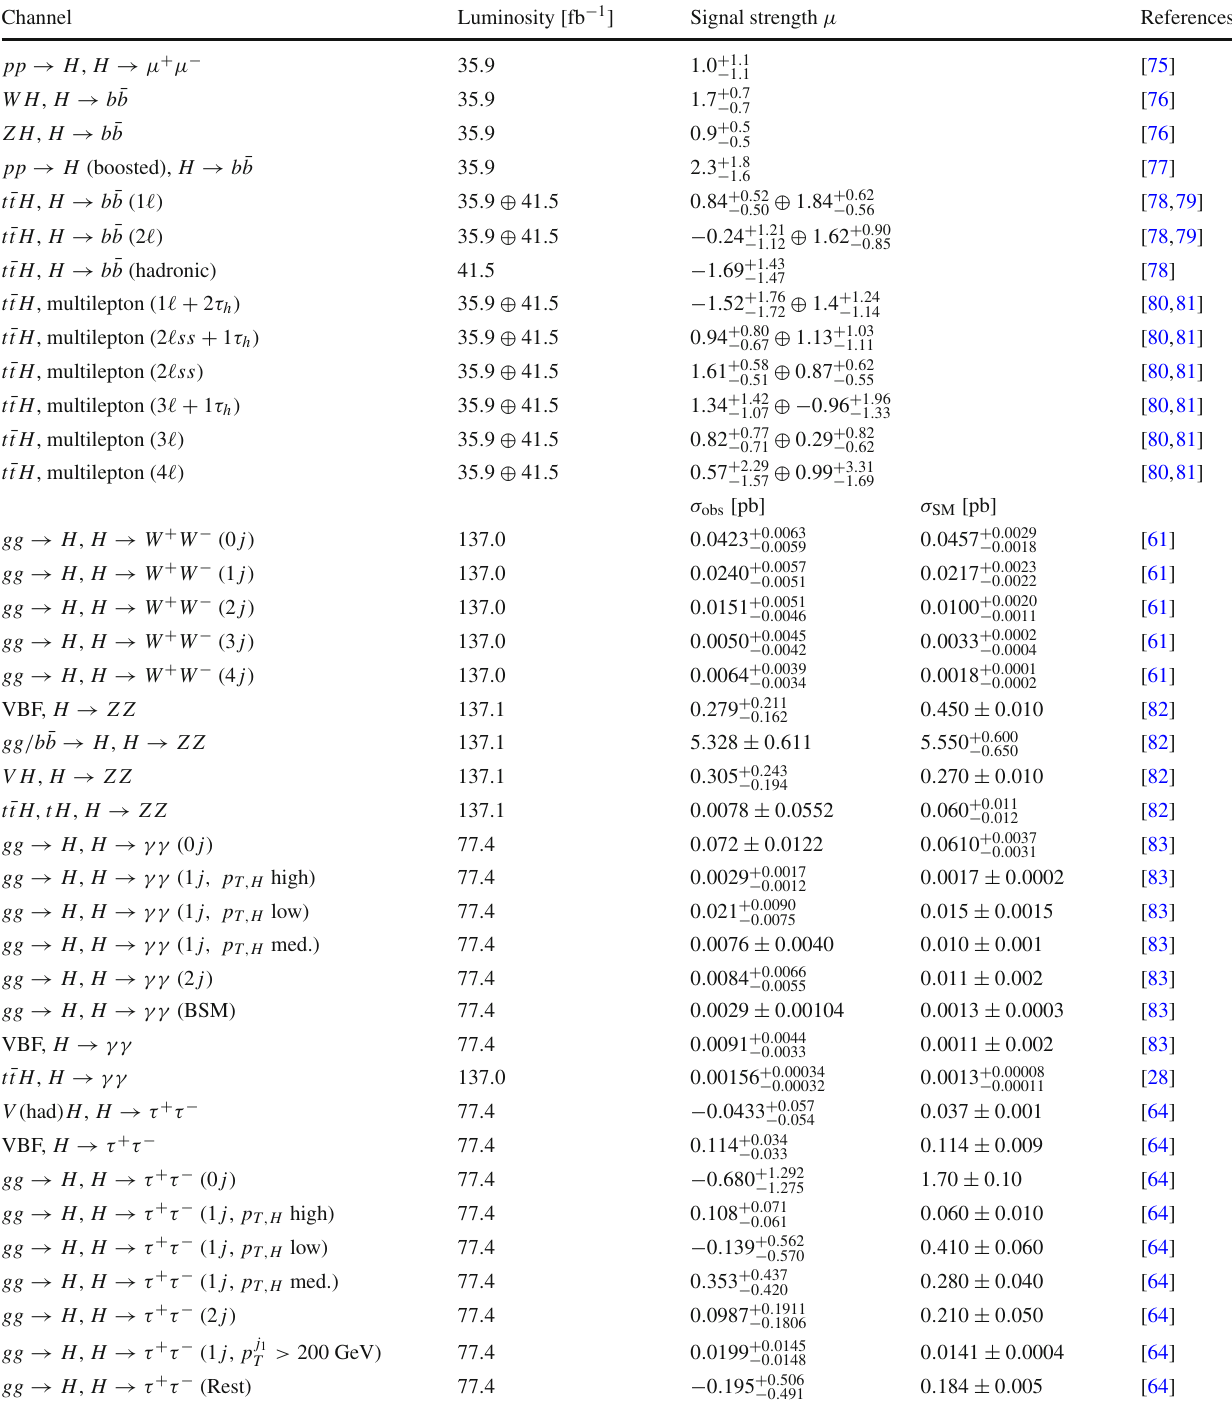
Table 7 CMS Higgs rate measurements from LHC Run-2 included in the default observable set LHC13_Apr2020 in HiggsSignals-2.6.0 Channel Luminosity [fb − 1 ] Signal strength